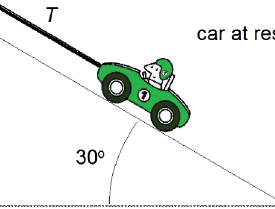
FIG. 2. Tension problem (the analogical